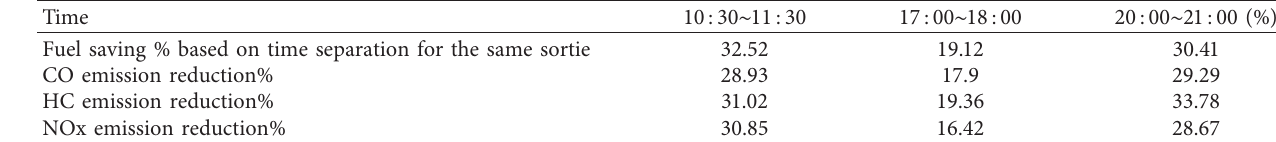
Table 17: Emission reduction percentage of fuel oil and various